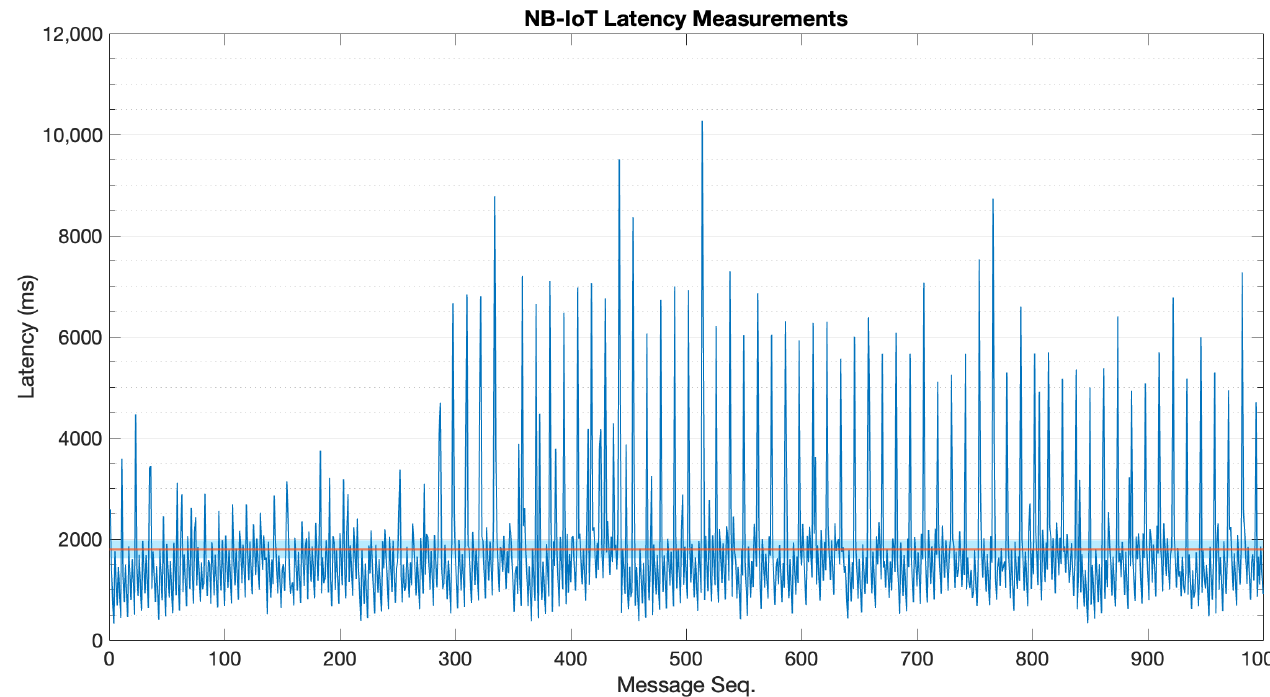
Figure A8. Latency plot for NB-IoT.